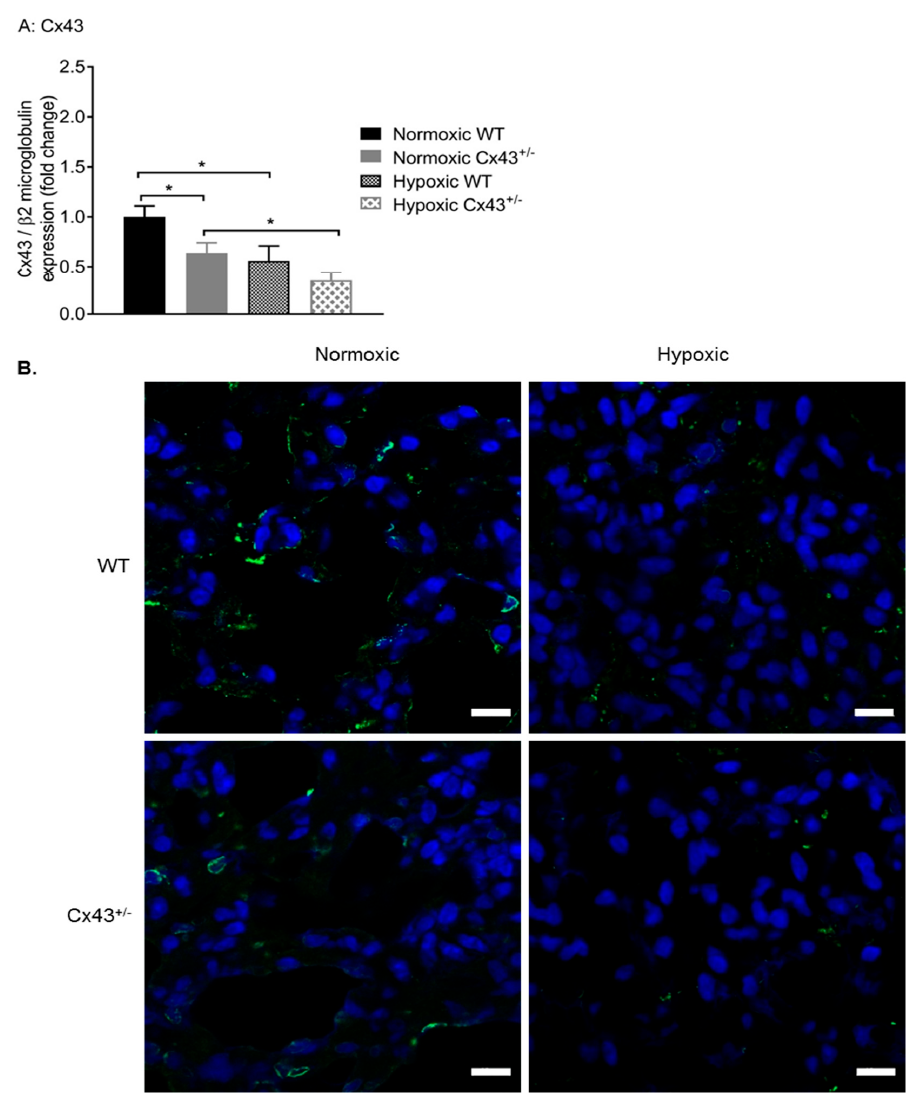
Figure 7. Cx43 expression in pulmonary arteries of wildtype (WT) and Cx43 heterozygous ( Cx43 +/ − ) mice under normoxic and chronic hypoxic conditions. Cx43 gene expression is reduced by hypoxia in both WT and Cx43 +/ − mice ( A ). Confocal images of Cx43 immunofluorescence staining in normoxic and hypoxic WT and Cx43 +/ − mouse lung tissue sections are shown in ( B ). Green fluorescence punctate findings represent Cx43 immunoreactivity and blue staining represents nuclei. Scale bars represent 10 µ m. For panel A , data is presented as mean ± S.E.M. and was analyzed by two-way ANOVA, * p < 0.05, n = 6 with each sample run in